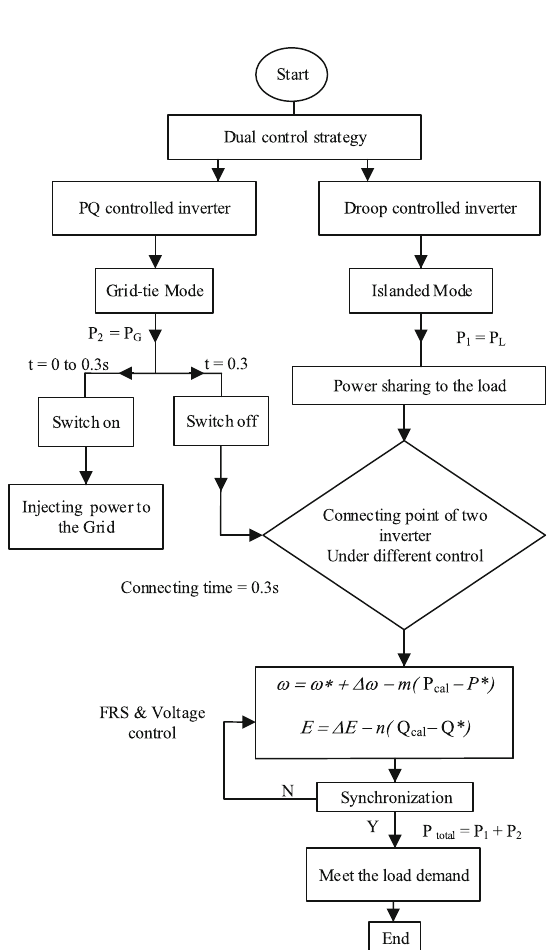
Fig. 7 Flowchart diagram of control